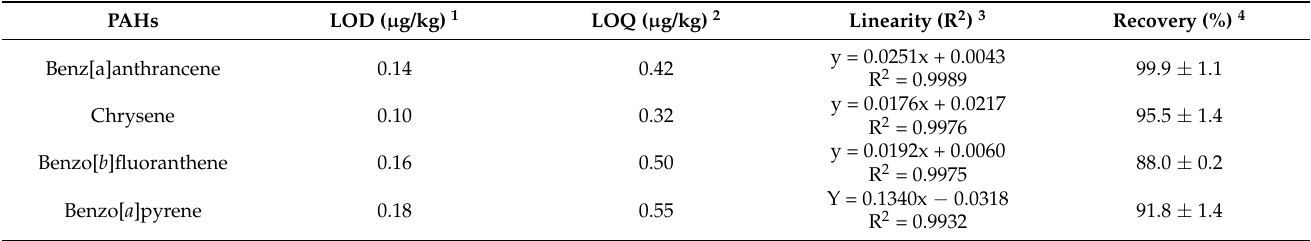
Table 2. The limit of detection (LOD), limit of quantification (LOQ), linearity, and recovery of each polycyclic aromatic hydrocarbons (PAHs).